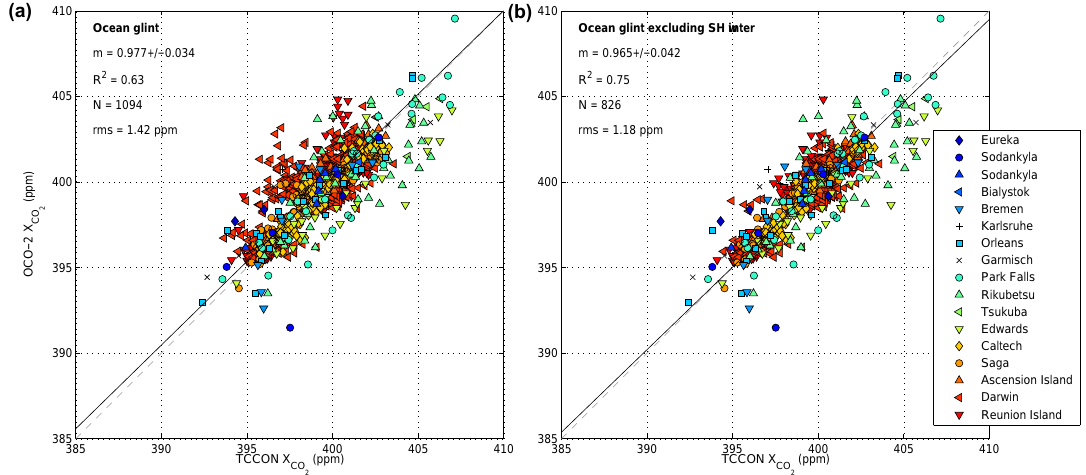
Figure 13. Ocean glint OCO-2 one-to-one plot against TCCON. The left panel shows all the glint-mode data. The right panel removes the Southern Hemisphere wintertime (June through September) glint data that have a known high bias. The annotations follow those in Fig.